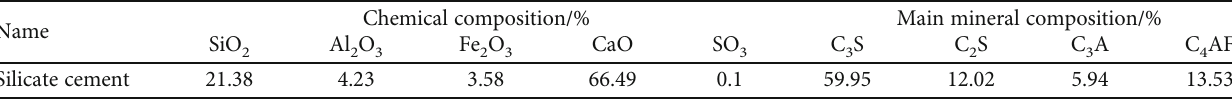
Table 1: The chemical and mineral composition of the silicate